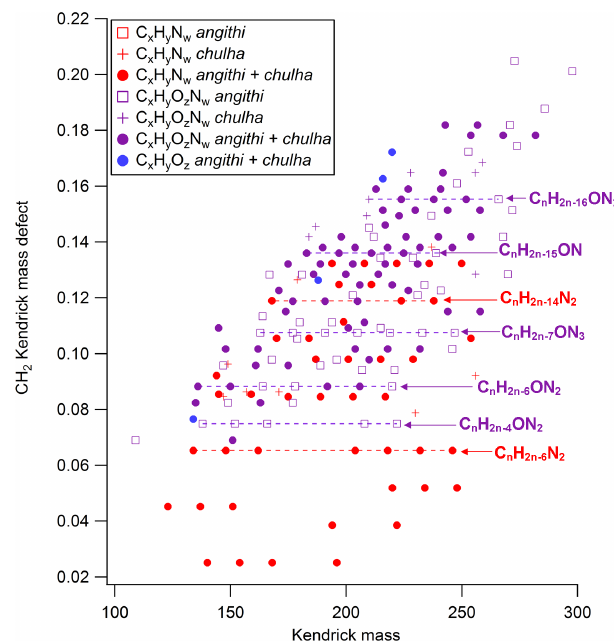
Figure 7. The CH 2 Kendrick mass defect plot for compounds emit- ted only from dung stoves. The marker color determines the com- pound category for C x H y N w compounds (red), C x H y O z (blue), or C x H y O z N w (purple). Marker shape indicates the stove(s) that re- producibly produced the compound: chulha and angithi ( • ), angithi ( (cid:3) ) , or chulha ( + ) . Homologous series are identified with dotted horizontal lines, suggesting that they have similar structures.